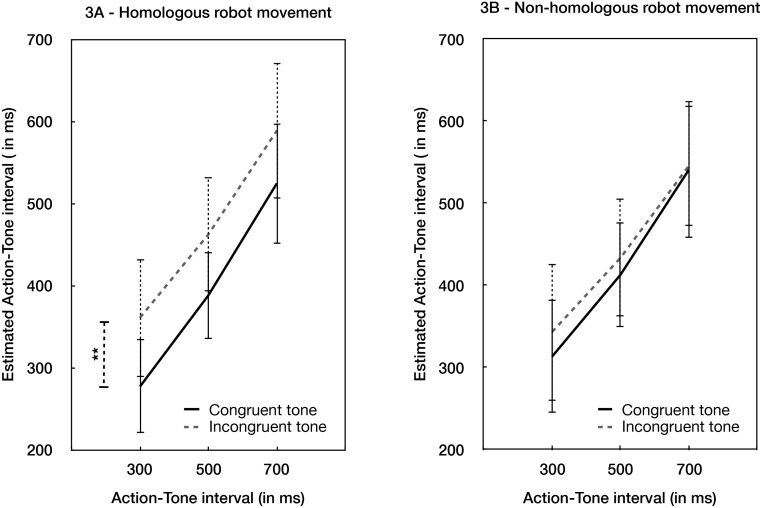
Behavioural Results.(A) Interval judgment estimation in the two experimental conditions in which the robot movement was homologous with the participant’s movement. (B) Interval judgment estimation in the two experimental conditions in which the robot movement was non-homologous with the participant’s movement. ** indicates a significant difference (two-tailed p < .01). Error bars refer to standard errors. All the tests were two-tailed.